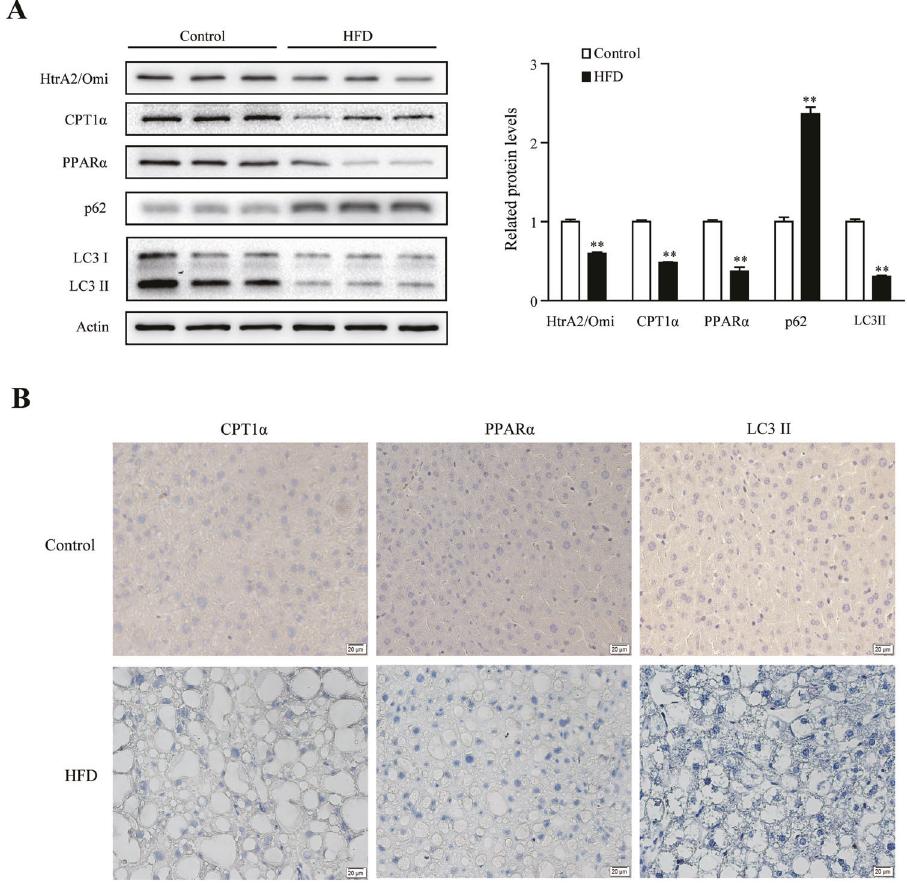
Fig. 1 Effect of a high-fat diet on hepatic HtrA2/Omi expression, limiting enzyme of β -oxidation, and autophagy-associated proteins in the liver during NAFLD progression. A Western blot analysis of HtrA2/Omi, CPT1 α , PPAR α , p62, and LC3I/II in liver tissues. The histogram shows the ratio quanti fi cation of band intensities ( n = 3). B Immunohistochemical staining of CPT1 α , PPAR α , and LC3II in the liver. scale bars: 20 μ m ( n = 6). Data are shown as means ± SEM. Student ’ s t test was used. ** P < 0.01 vs. control